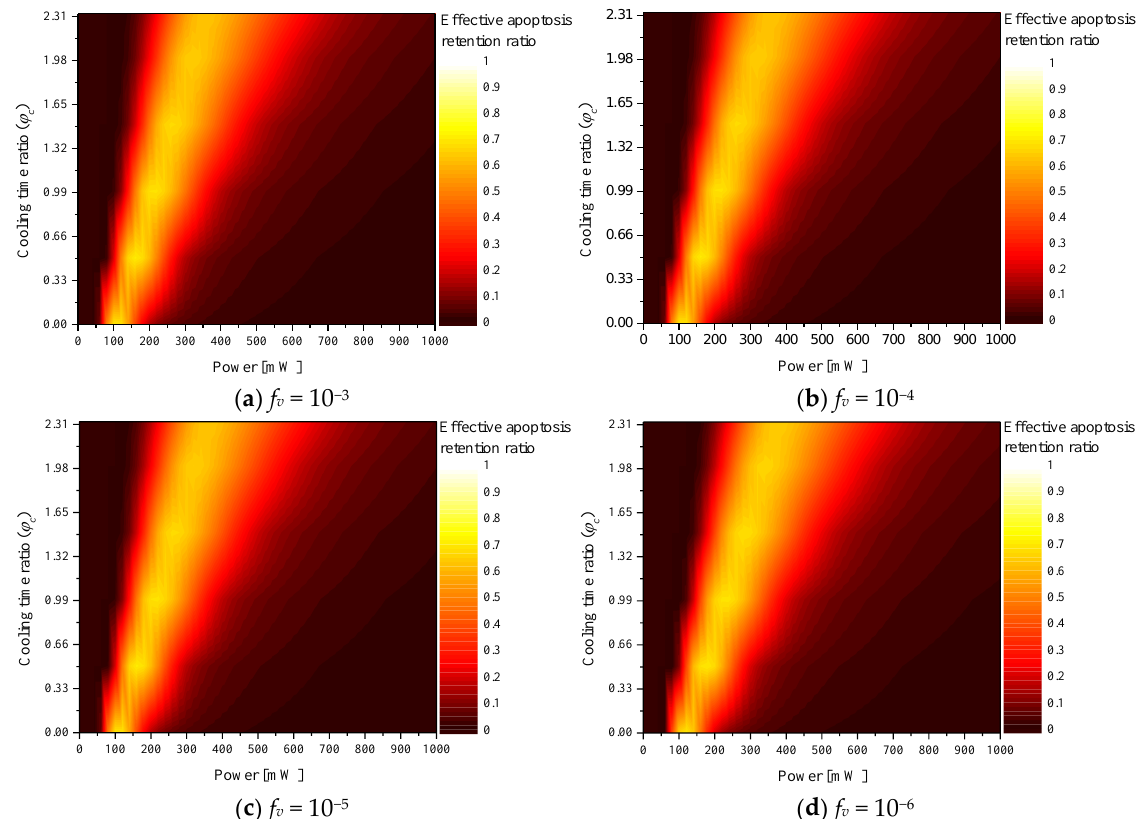
Figure 5. Effective apoptosis retention ratio ( 𝜃 𝑒𝑓𝑓∗ ) for various cooling time ratios ( φ c ).